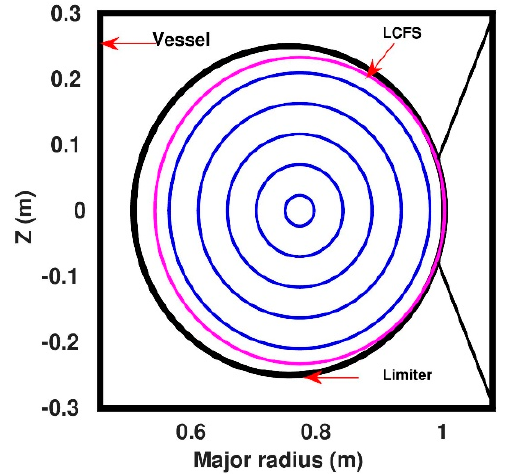
Figure 1. The center of the contour of flux surfaces is located at R 0 = 0.767 m and Z 0 = 0.0 m and the geometrical center of ring-limiter is at major radius (R) = 0.75m and Z = 0.0m.